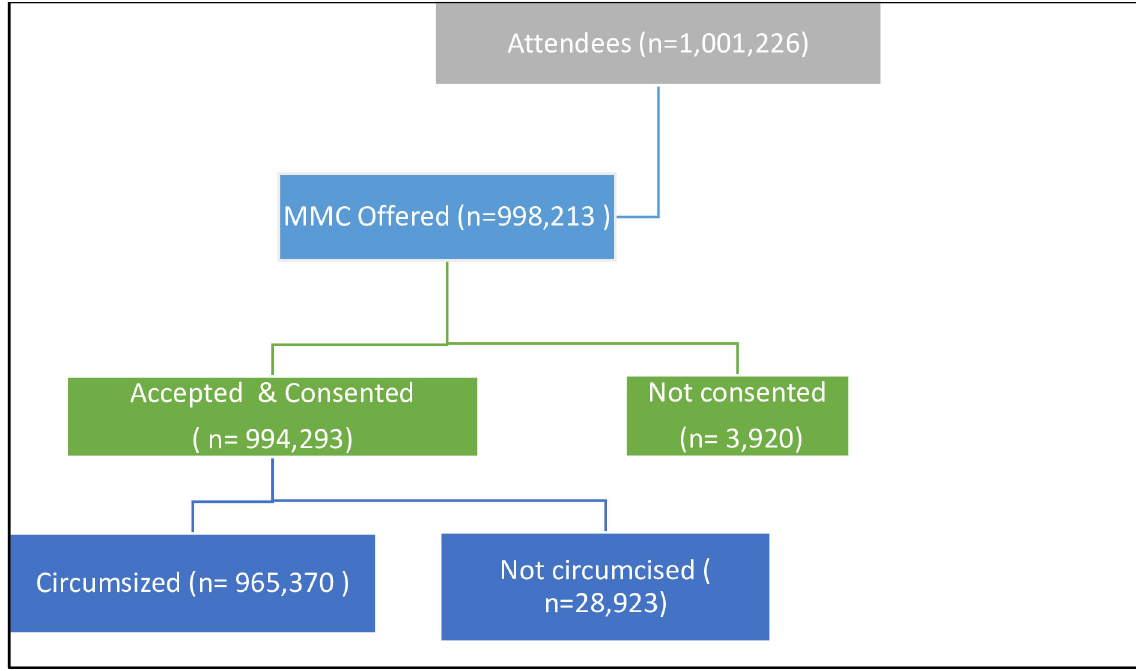
Fig 2. Flow of participants for the VMMC